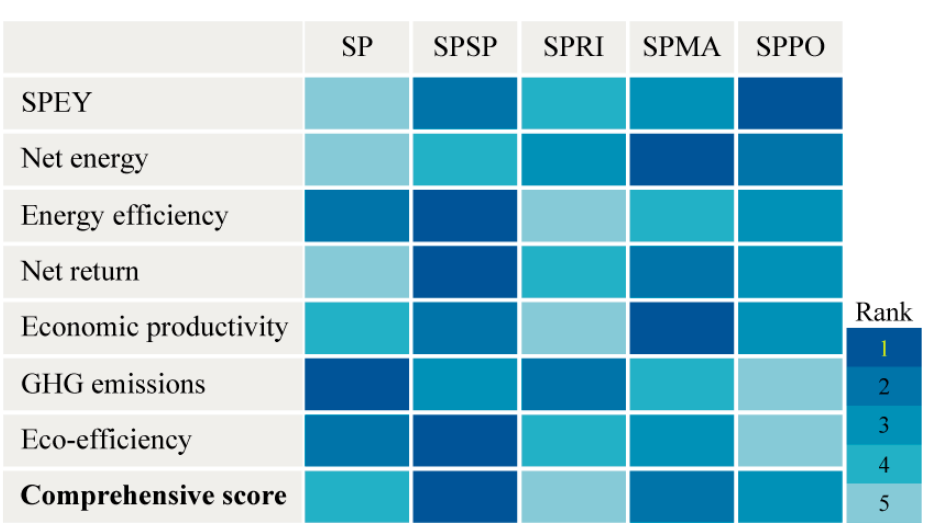
Figure 6. Comprehensive assessment of sweet-potato-based cropping systems in Guangdong province. For each parameter, the change of color from dark to light in a row indicates the order of cropping systems from high to low. SP: sweet potato monocropping; SPSP: sweet potato continuous cropping; SPRI: sweet potato and rice rotation; SPMA: sweet potato and maize rotation; SPPO: sweet potato and potato rotation; and SPEY: sweet potato equivalent yield.